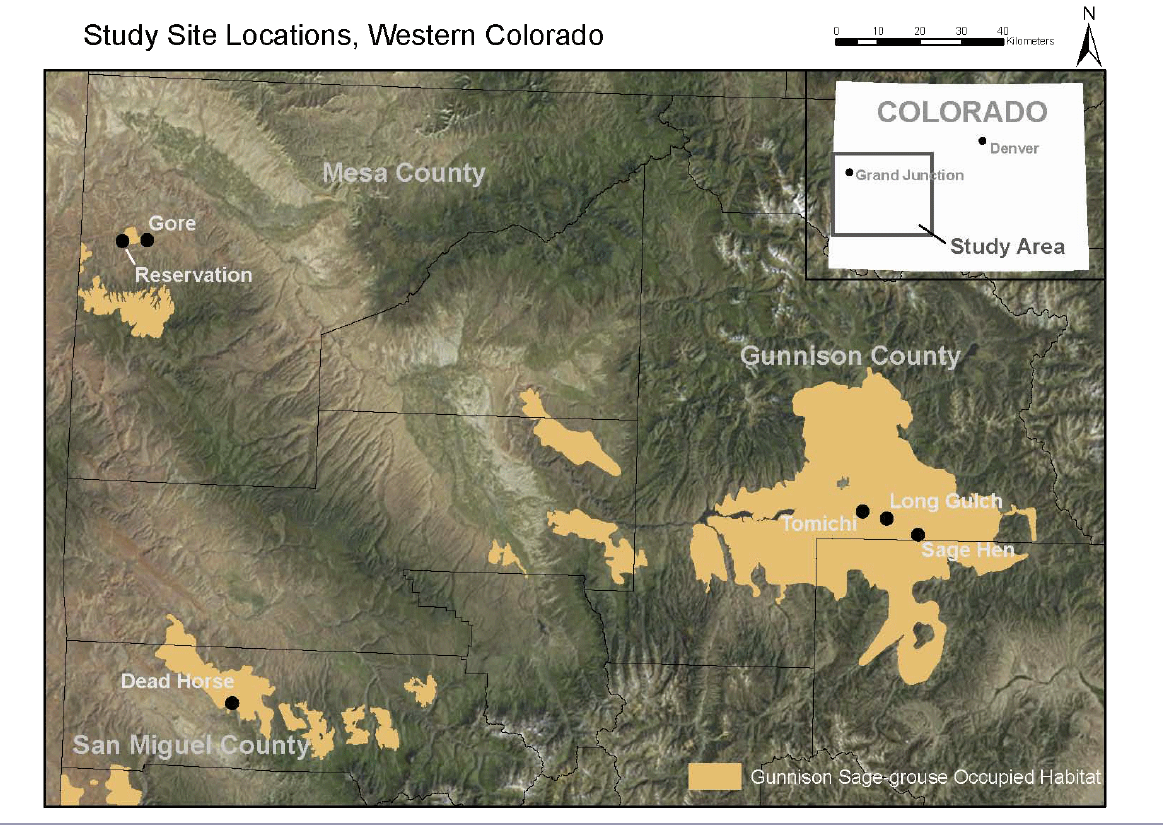
Fig. 1 . Occupied Gunnison Sage-Grouse ( Centrocercus minimus ) range (shading) and sagebrush habitat treatment sites in Colorado